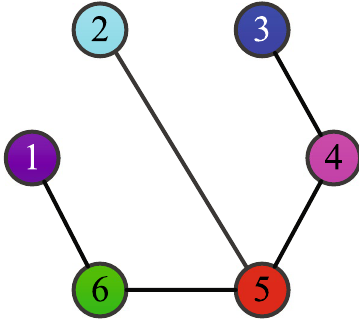
Figure 1. Information